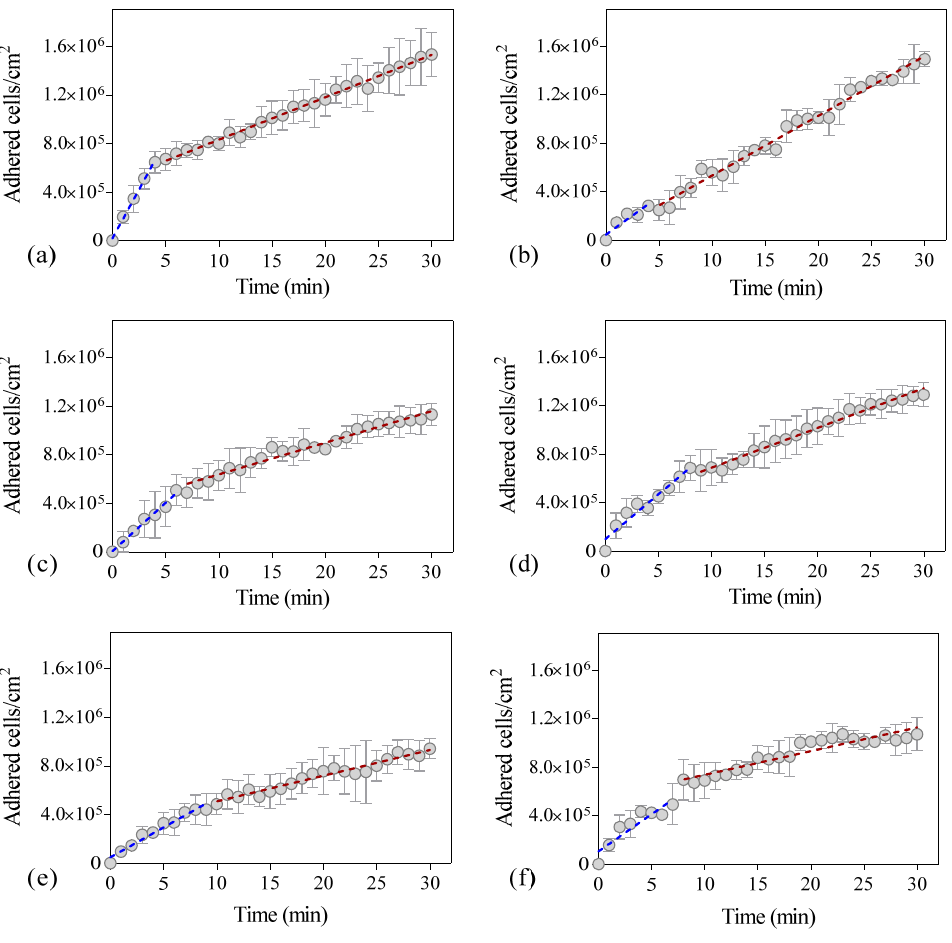
Figure 2. Number of Escherichia coli cells adhered to polydimethylsiloxane (PDMS) as a function of time. The dashed line indicates the best fit to a linear function for the initial adhesion rate (blue) and final adhesion rate (red) of the experiments. The adhesion assays were performed during 30 min at different flow rates: ( a ) 1 mL/s, ( b ) 2 mL/s, ( c ) 4 mL/s ( d ) 6 mL/s, ( e ) 8 mL/s, and ( f ) 10 mL/s corresponding to shear rates of 7.5/s, 15.0/s, 33.7/s, 51.6/s, 80.3/s, and 100.8/s, respectively, in a parallel plate flow cell (PPFC). Error bars indicate the standard deviation from three independent experiments.